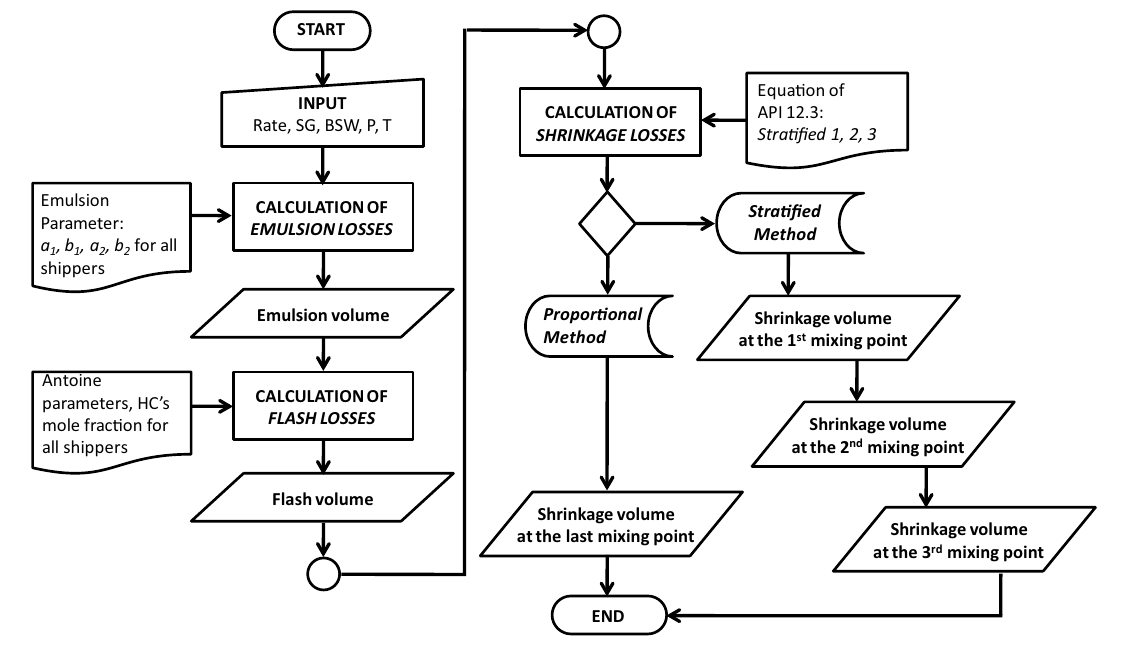
Fig. 3 Calculation algorithm of sharing oil losses